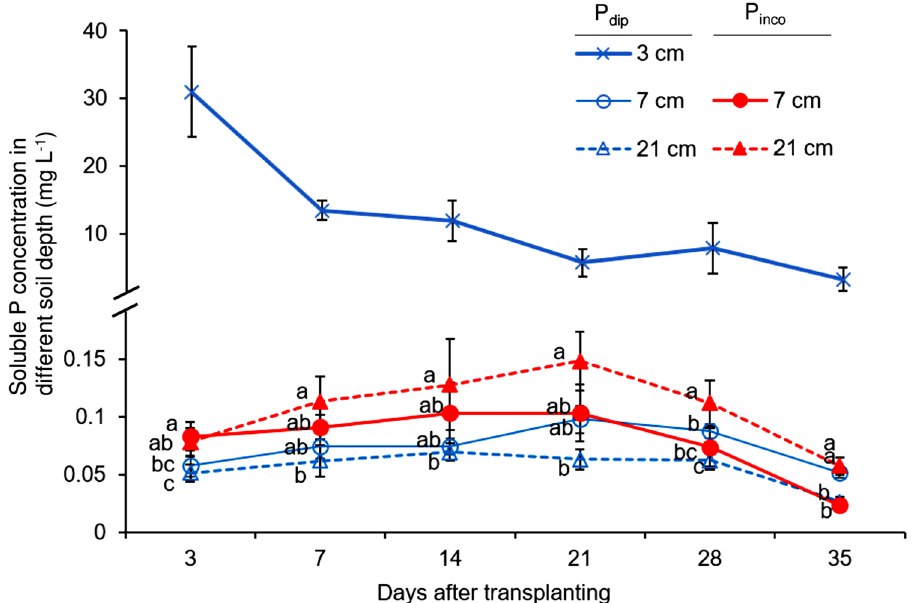
Figure 6. Spatio-temporal variations in soluble P concentration as affected by different P application methods. The cross symbols indicate the value at the 3 cm depth of the P-dipping (P dip ) treatment. The open and closed circles indicate the value at the 7 cm depth of the P dip treatment, and P incoropration (P inco ) treatment, respectively. The open and closed triangles indicate the value at the 21 cm depth of the P dip treatment and P inco treatment, respectively. Data values are an average of three rice genotypes because no significant genotype difference in soluble P concentration was observed at each sampling time. Error bars indicate standard error of replications. Different letters indicate significant differences at 5% using Tukey’s HSD test among different soil depths (7 cm and 21 cm) by P application methods. The observation at 3 cm depth was only conducted in the P dip